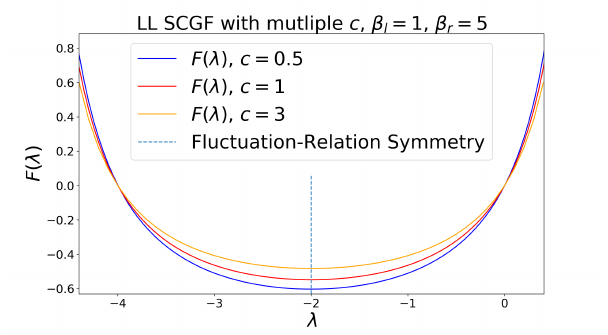
= 1 β = 5 and various values of c . The FR l r − β ) / 2, is again shown by the dotted l r